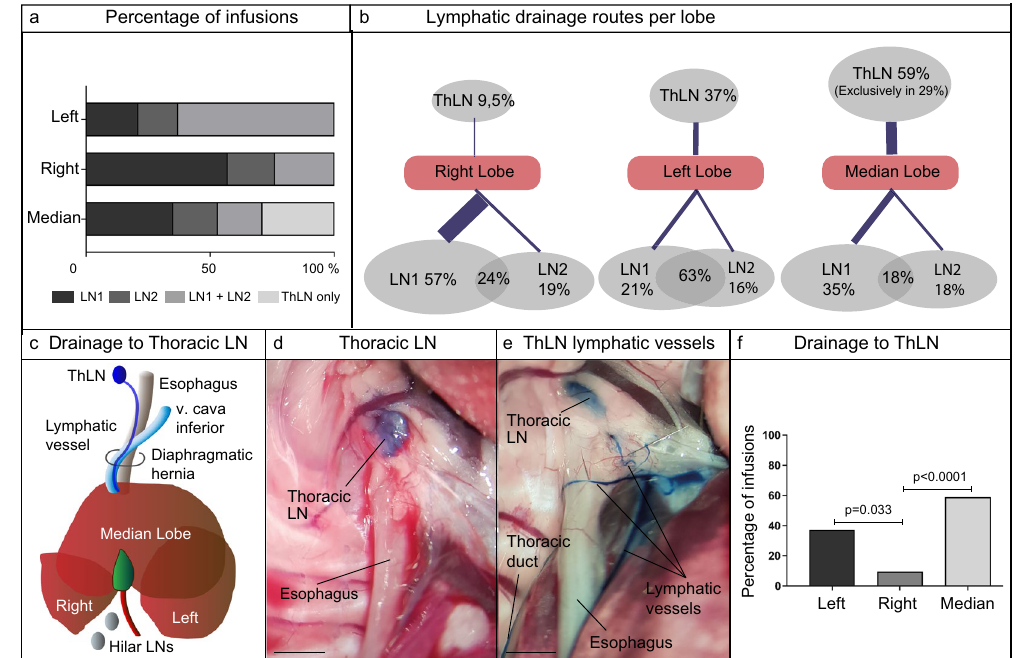
Figure 3. In vivo lymphangiography shows preferential drainage patterns per lobe. ( a ) Bar graph of Evan’s blue dye lobar drainage patterns (data shown are percentages). ( b ) Schematic overview of observed Evan’s blue dye drainage to LN1, LN2, combination LN1 + LN2 and ThLN per lobe. ( c ) Schematic overview of lymphatic drainage to ThLN, supplied by lymphatics running along the inferior vena cava and the esophagus. ( d ) Representative image of dye accumulation in ThLN. Scale bar = 2 mm. ( e ) Representative image of the direct lymphatic connection from the liver, running along the esophagus. This direct lymphatic route was observed in all blue-stained ThLN (total n = 19). Scale bar = 2 mm. ( f ) Bar graph of Evan’s blue dye drainage to ThLN per lobe (data shown are percentages). For the analysis of the Evan’s blue dye lymphangiographies, a Generalized Estimation Equation (GEE) model was used. For this model, it was notated per unit (per mouse) where the infusion site was (Left, Right or Median lobe) and at which location blue color dye was observed (LN1, LN2, ThLN). The data itself was notated categorically: either blue dye was observed (designated “1”) or not observed (designated “0”). Pairwise comparisons (Wald-Chi square tests) were performed for all-level combinations. Figure represents the pairwise comparison for lobe infusions and the concomitant positive coloring of ThLN. The infused lobe with the lowest percentage of positive ThLNs was used as reference point for the